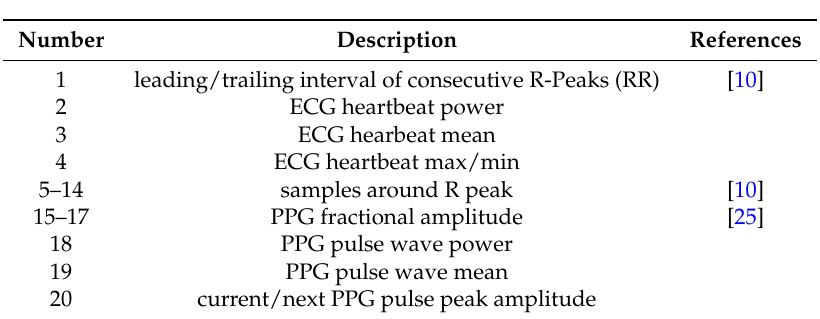
Table 1. Electrocardiography (ECG) and photoplethysmography (PPG) derived features, which are extracted from each heart beat and processed by the presented multimodal ectopic beat detector. All features can be calculated with information drawn from the preceding and following heartbeat only, which allows for a small memory footprint and low detection delay. Furthermore, they are designed to adequately reflect both major classes of ectopic